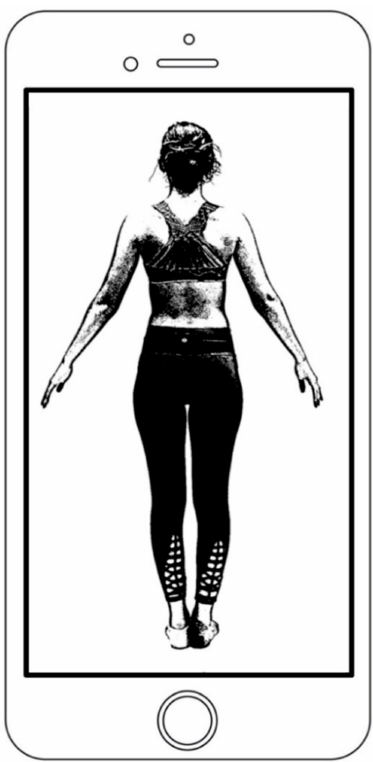
Figure 1. An example of appropriate clothing and body positioning that was used for each scan within the smartphone application’s 2D image analysis